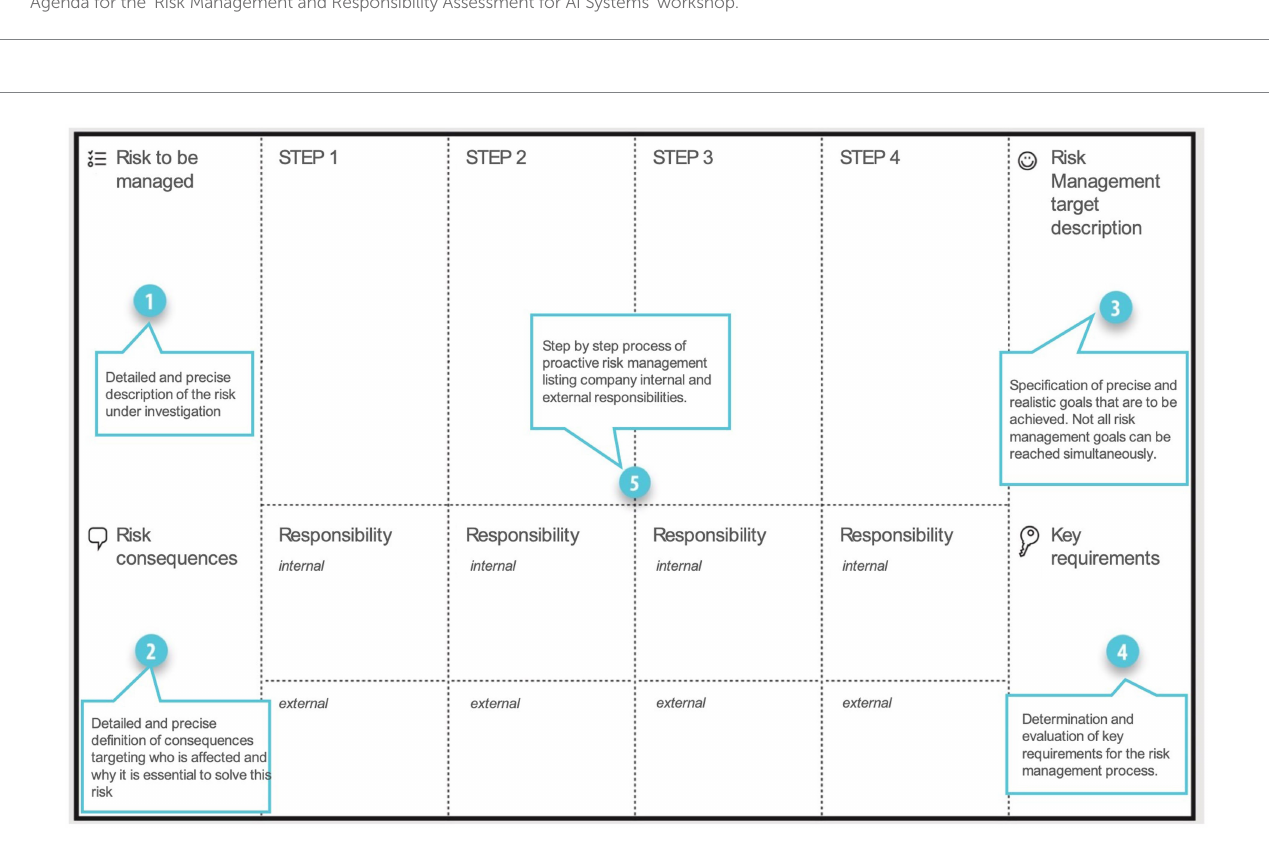
FIGURE 5 Outline for the AI risk management prototyping